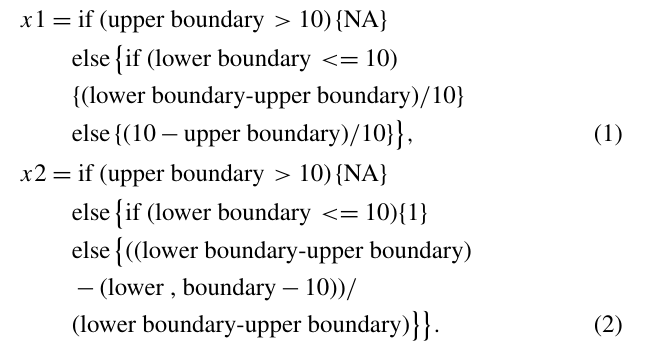
Figure 2. Typical soil profiles under the four vegetation categories.